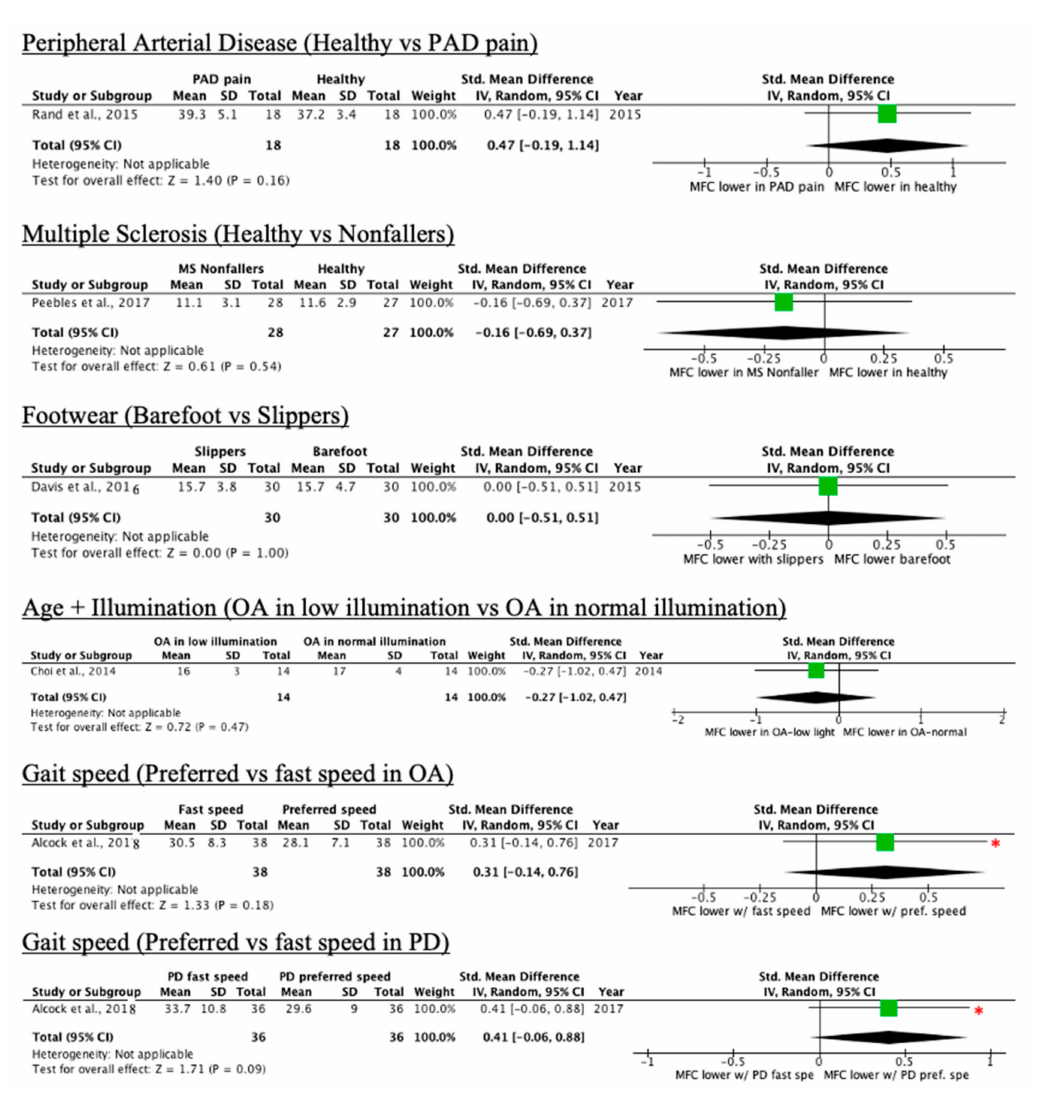
Figure 5. Forest plots of conditions comprising one study without an overall MFC mean effect relative to control (* = original manuscript reports different finding; OA = older adults, YA = younger adults, PD = Parkinson’s